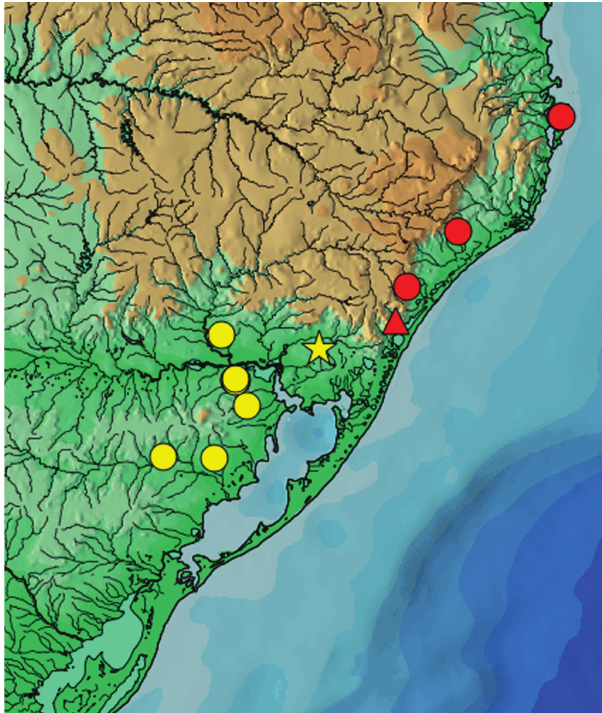
Fig. 8. Map of northern Rio Grande do Sul State and southern Santa Catarina State, Brazil, showing the distribution of Scleromystax reisi in the laguna dos Patos drainage (yellow symbols; star = type locality) and the distribution of S. salmacis (red symbols; triangle = first record to the rio Tramandaí